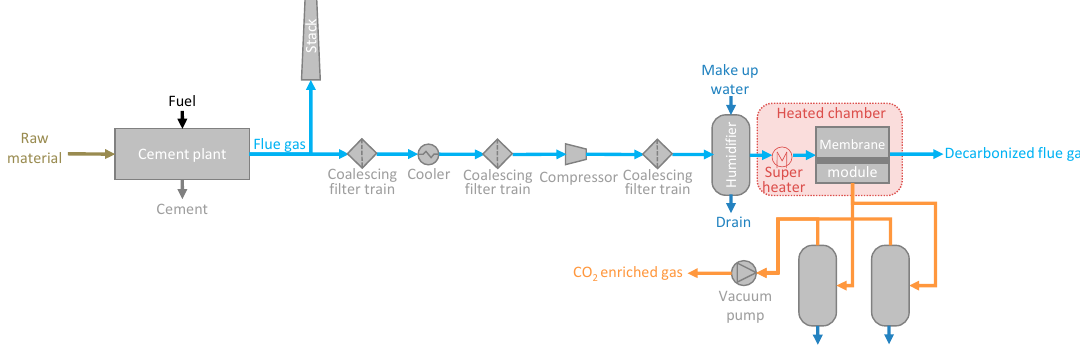
Figure 7. Simplified flow diagram of the pilot membrane unit tested at Brevik cement plant (adapted from [51]).